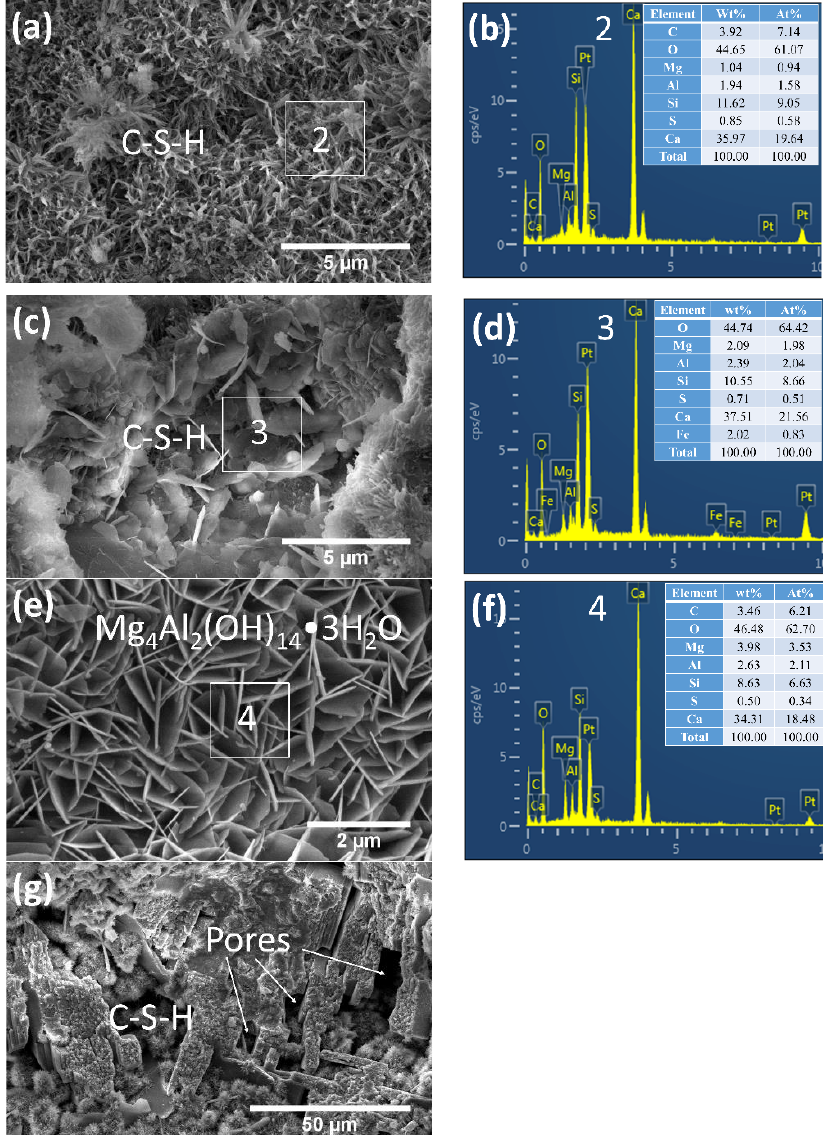
Figure 5. SEM images of pure cement paste after 80 °C steam curing for 7 h, ( a ) fibrous C-S-H gels; ( b ) EDS result of area 1; ( c ) pores. Note: Wt% represents the mass percentage, At% represents the atomic percentage.